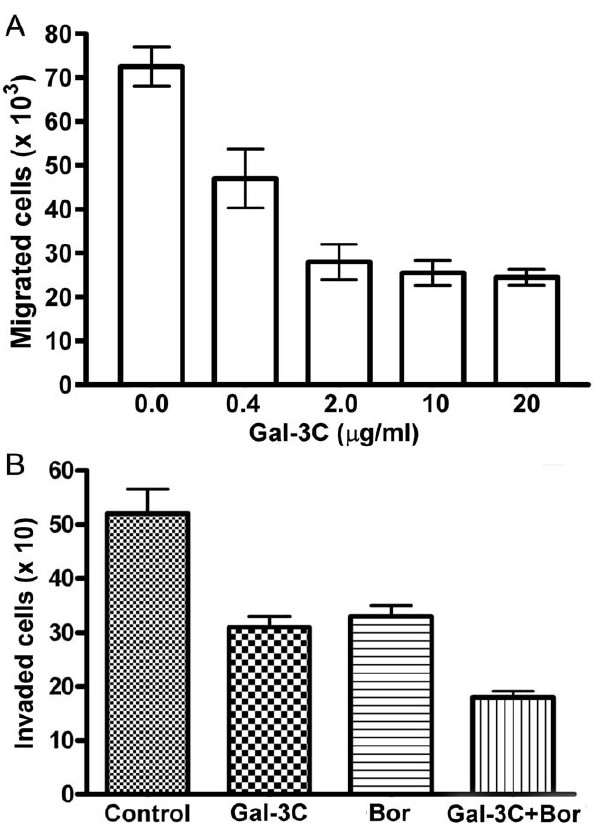
Figure 2. Gal-3C inhibits the chemotaxis and invasion of U266 MM cells. ( a ) Gal-3C (0.4, 2, 10, or 20 m g/ml) reduces the chemotaxis of U266 cells in bicameral chambers in response to SDF-1 a (100 ng/ml). Error bars are 6 S.D. and sextuplicate data points are represented (ANOVA with Tukey test P , 0.001 for all compared to controls). ( b ) The effect of Gal-3C and Bor on invasion activity of U266 cells. After starvation in serum-free medium for 3 h, U266 cells were plated on Matrigel-coated inserts in the upper chambers. The number of cells which migrated through the Matrigel and filter from the upper chamber and were adhering to the bottom of the insert were quantified by counting using a microscope. Gal-3C (10 m g/ml) and Bor (5 nM), and the combination of both significantly inhibited ( P , 0.05) U266 cell invasion. Experiments were done in triplicate and repeated three times. Error bars represent 6